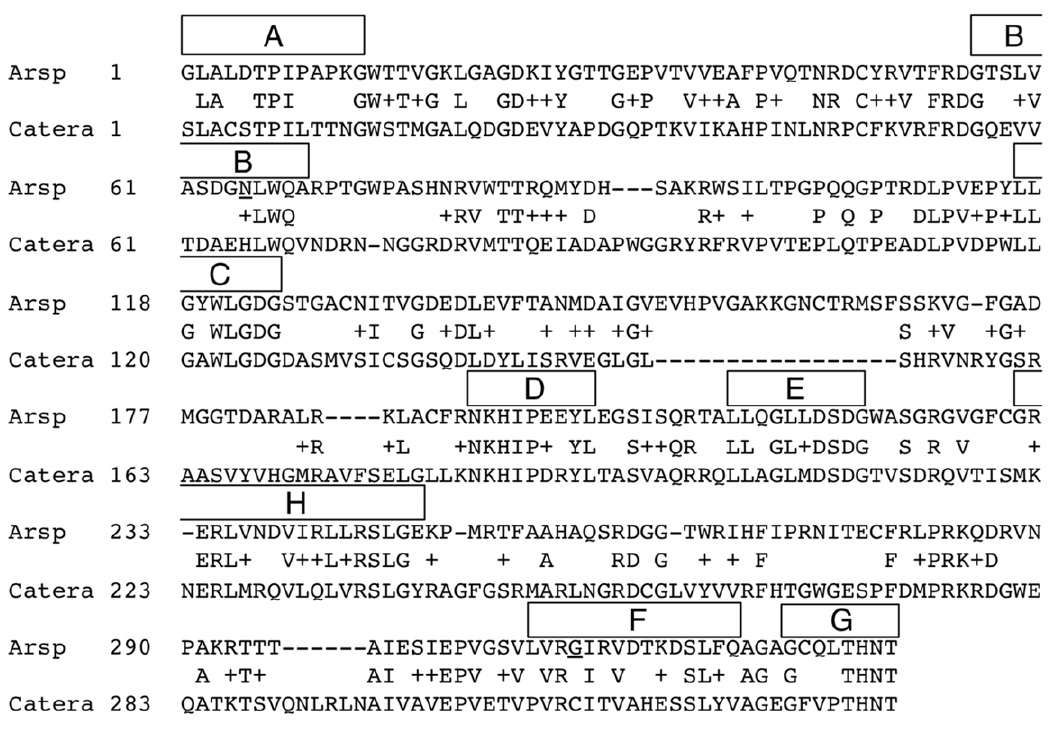
Figure 1. Sequence alignment of the Arsp-FB24 Arth_1007 intein (Arsp) vs. the MP-Catera Gp206 intein (Catera). Conserved splicing motifs (A, B, F, and G) and homing endonuclease motifs (C, D, E and H), as described in the InBase intein database [2,3,4,6], are indicated above the Arsp-FB24 Arth_1007 intein sequence. Positions within each motif are numbered from amino to carboxy terminal and are referred to using the motif letter and the position number separated by a colon. Arsp-FB24 Arth_1007 intein residues Asn 65 in Motif B position 10 (B:10) and Gly 311 in Motif F position 4 (F:4) are underlined. Residues present in both inteins are listed and similar substitutions are marked with a plus sign.